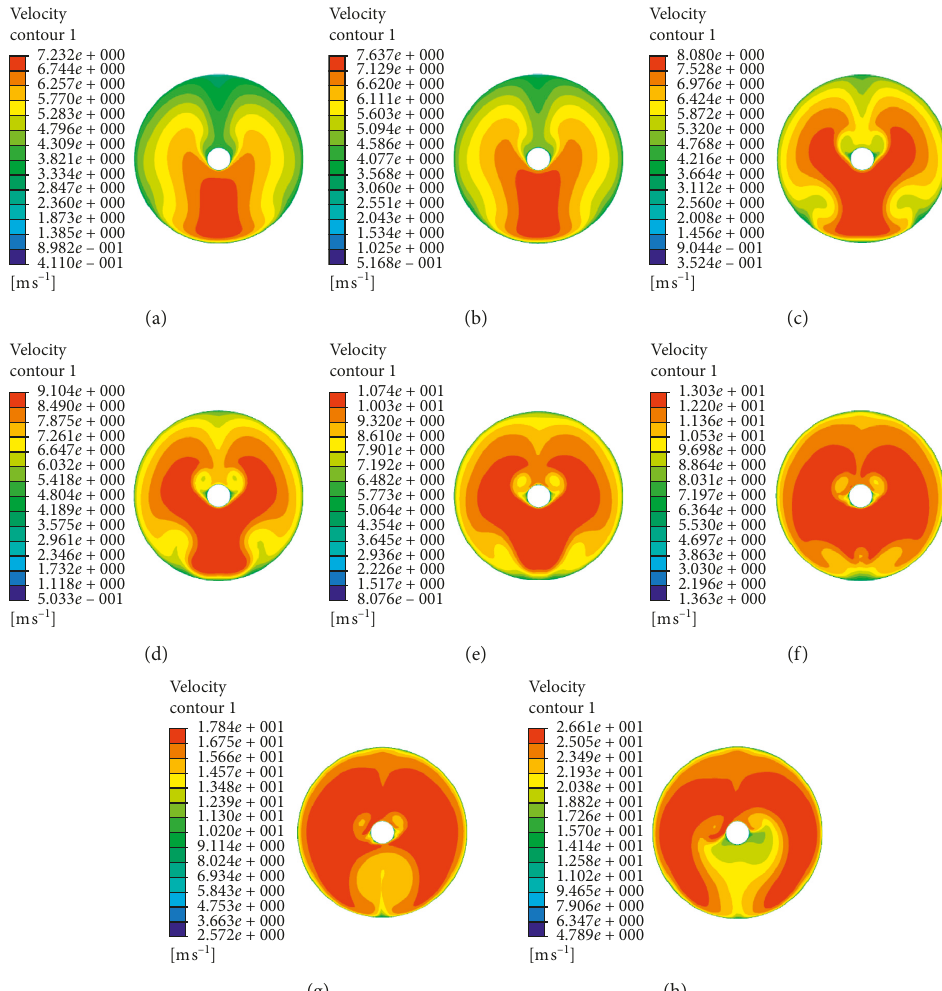
Figure 10: Velocity distribution contours at the outlet section of inlet passage with different IVRs. (a) 0.5, (b) 0.59, (c) 0.67, (d) 0.78, (e) 0.94, (f) 1.18, (g) 1.64, and (h)